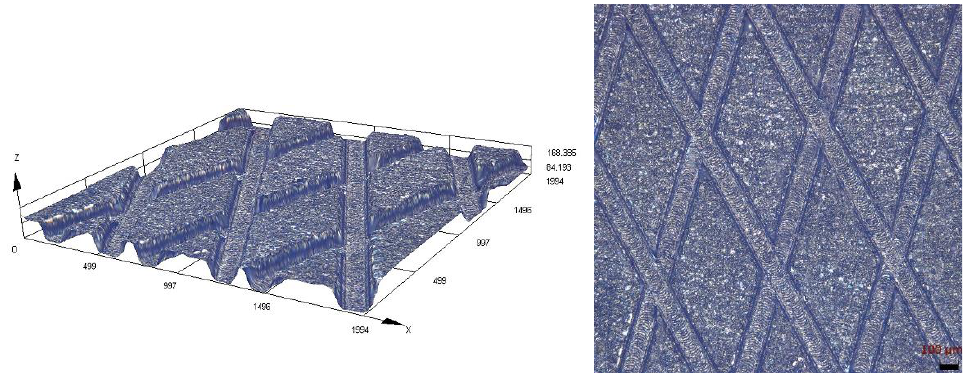
Figure 2. Morphology of the reticular